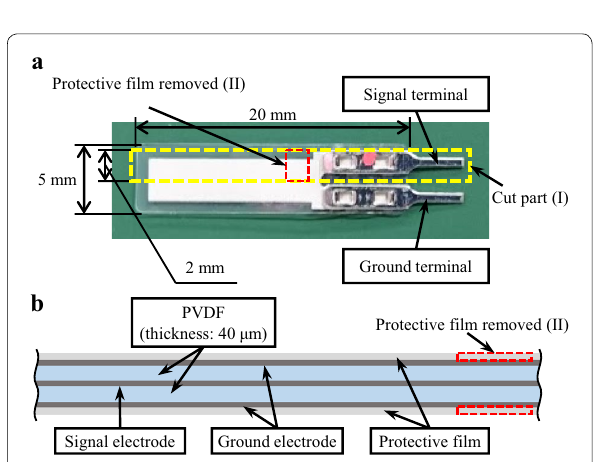
Fig. 2 Processing of the piezoelectric film. a Photograph.